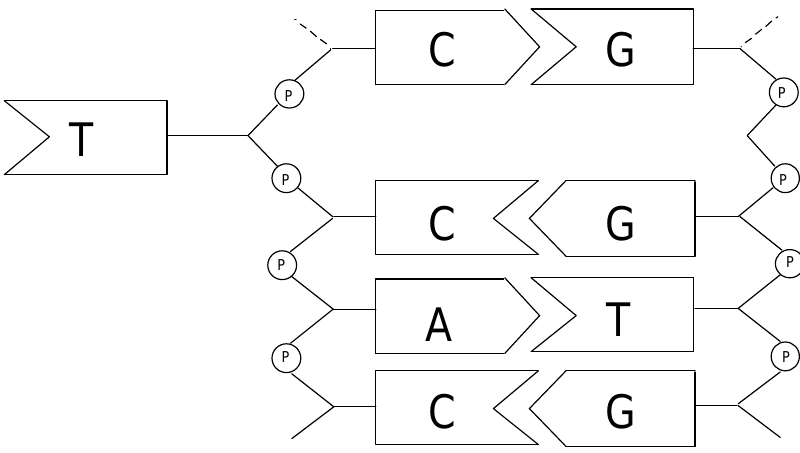
Figure 10. Schematic representation of an apurinic